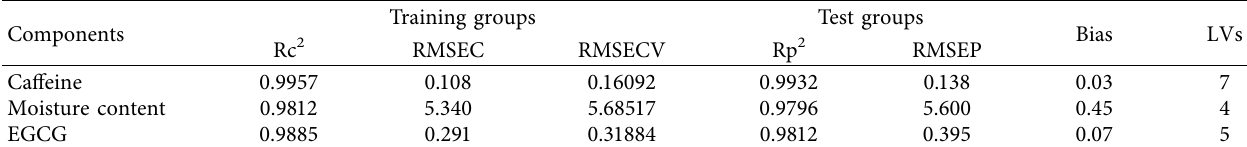
Table 4: Data for the three indexes of the best calibration model